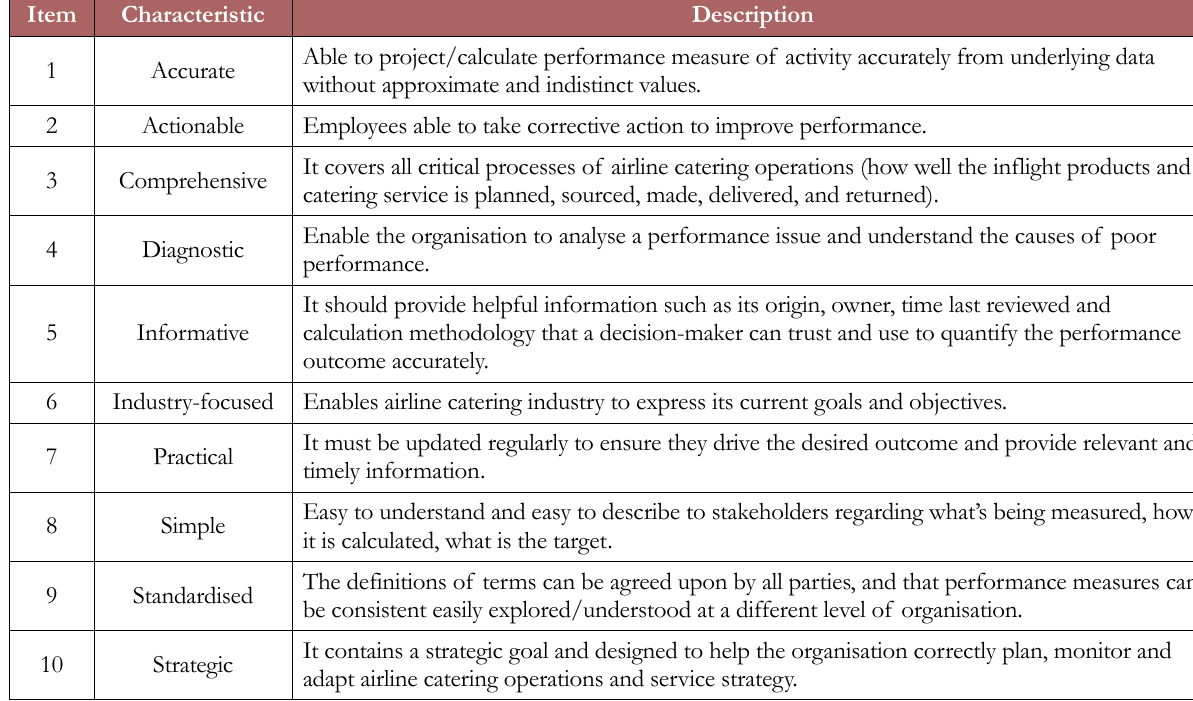
Table 1. Characteristics of effective performance metrics for adaptation in airline catering supply